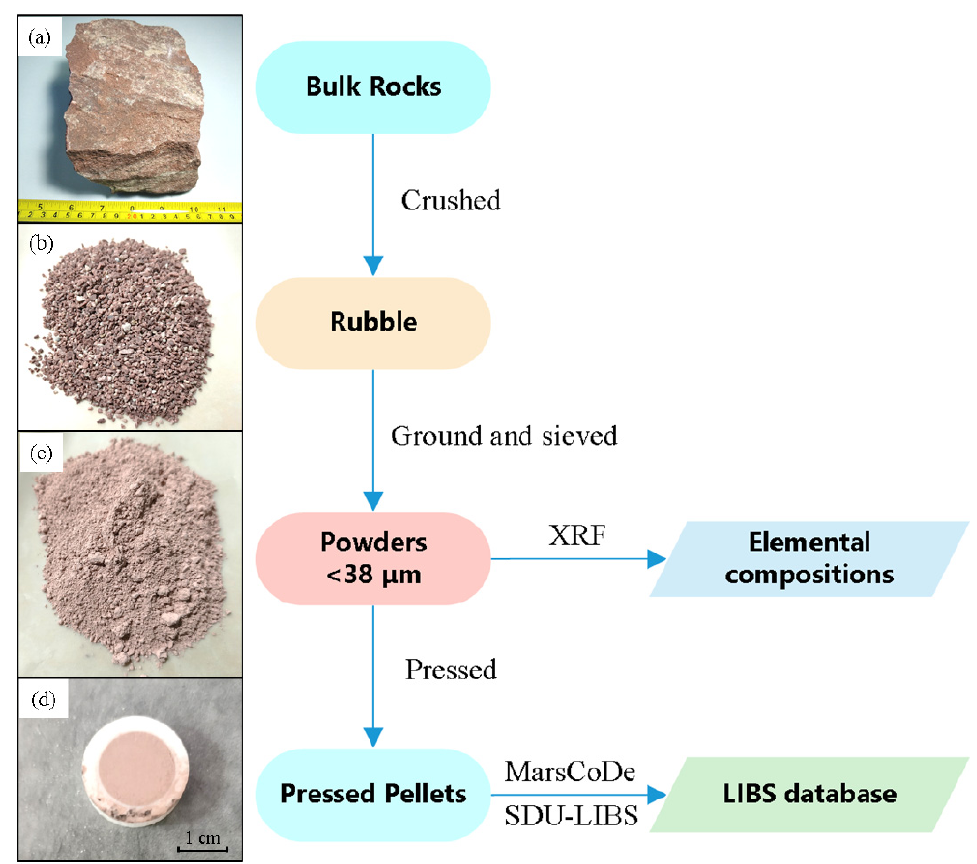
Figure 1. Scheme for MAL standards preparation and images of feldspathic quartz sandstone